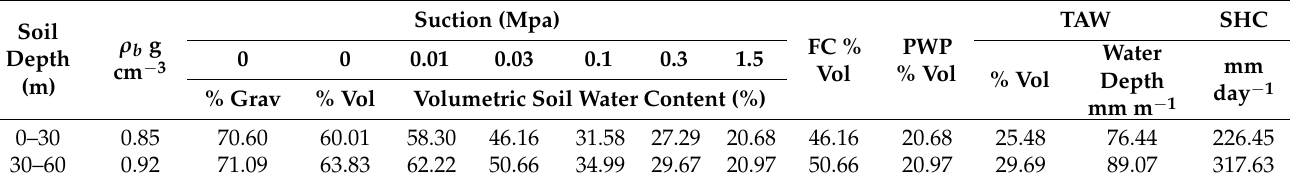
Table 2. Physical characteristics of the soil in the experimental site.